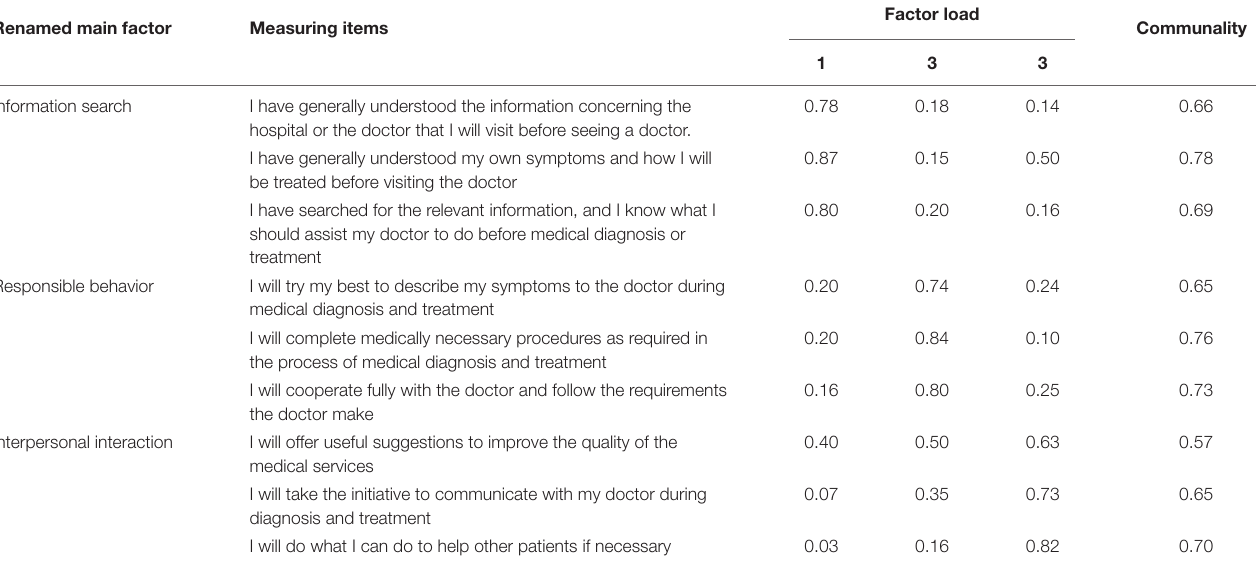
TABLE 4 | Factor loading matrices for patient